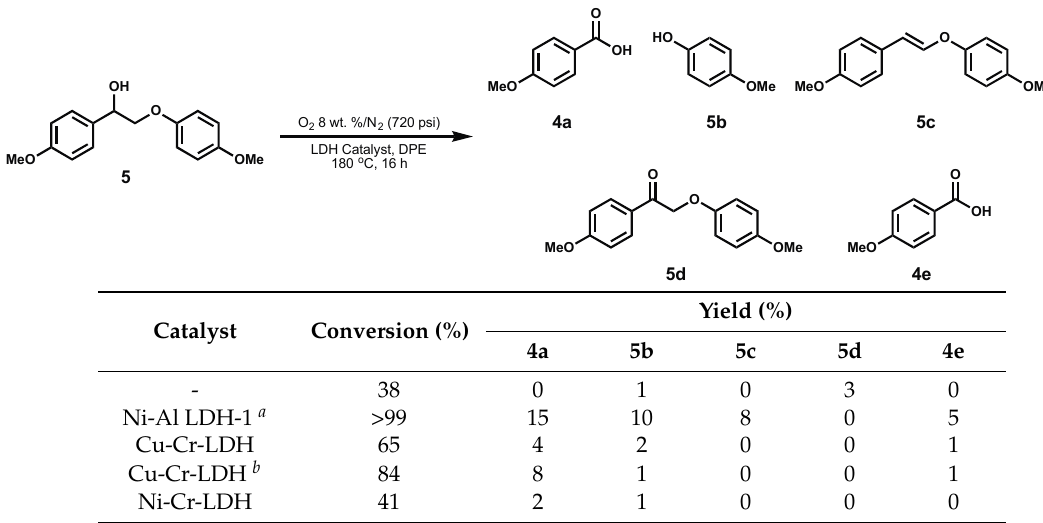
Table 10. Conversion of 5 over LDH catalysts in phenyl ether with O 2 .